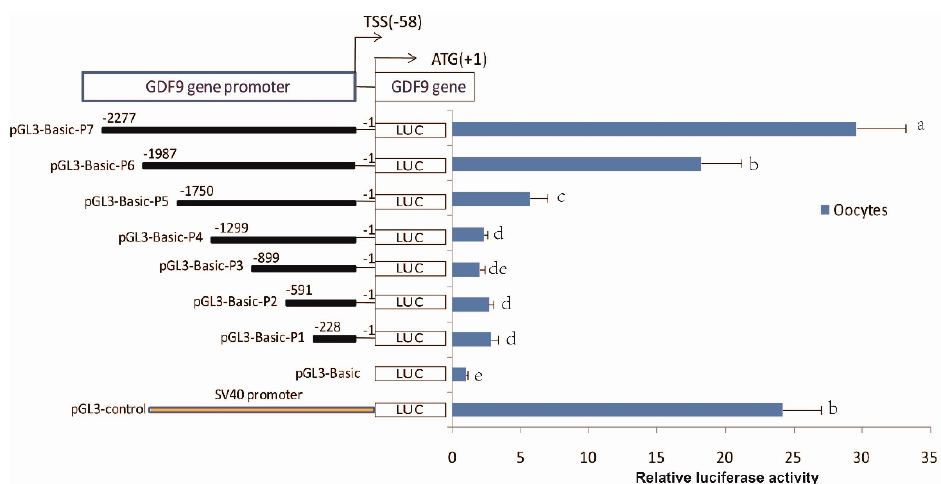
Figure 4. Identification of the core region of the ovine GDF9 promoter. Truncated 5 ′ -flanking sequences of the GDF9 are labeled on the left panel and include pGL3-basic-P1 ( − 1/ − 228), pGL3-basic-P2 ( − 1/ − 591), pGL3-basic-P3 ( − 1/ − 899), pGL3-basic-P4 ( − 1/ − 1299), pGL3-basic-P5 ( − 1/ − 1750), pGL3-basic-P6 ( − 1/ − 1987), and pGL3-basic-P7 ( − 1/ − 2277). The luciferase activities of the promoter fragments in oocytes are shown on the right panel. Data of three independent replicates are presented as means ± SD. Each of the adjacent lowercase letters represent significant differences ( p < 0.05).